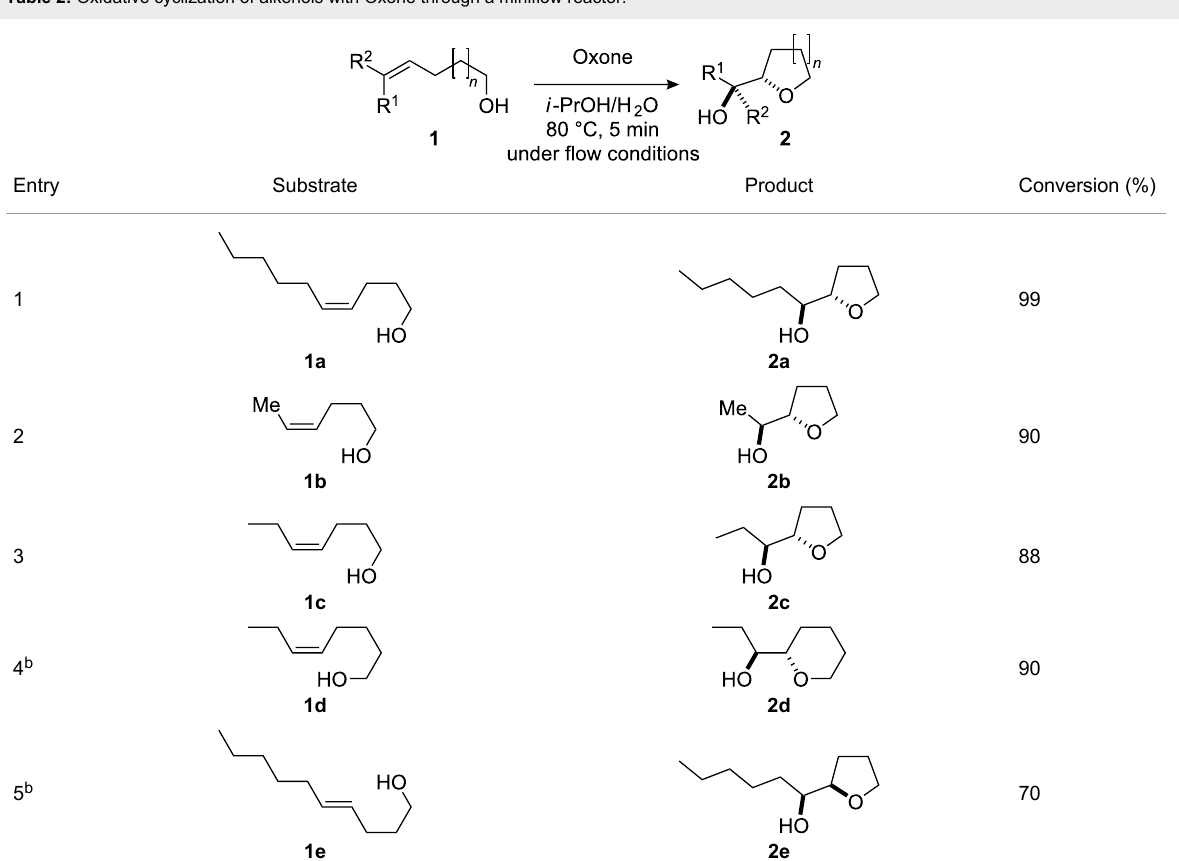
Table 2: Oxidative cyclization of alkenols with Oxone through a miniflow reactor. a